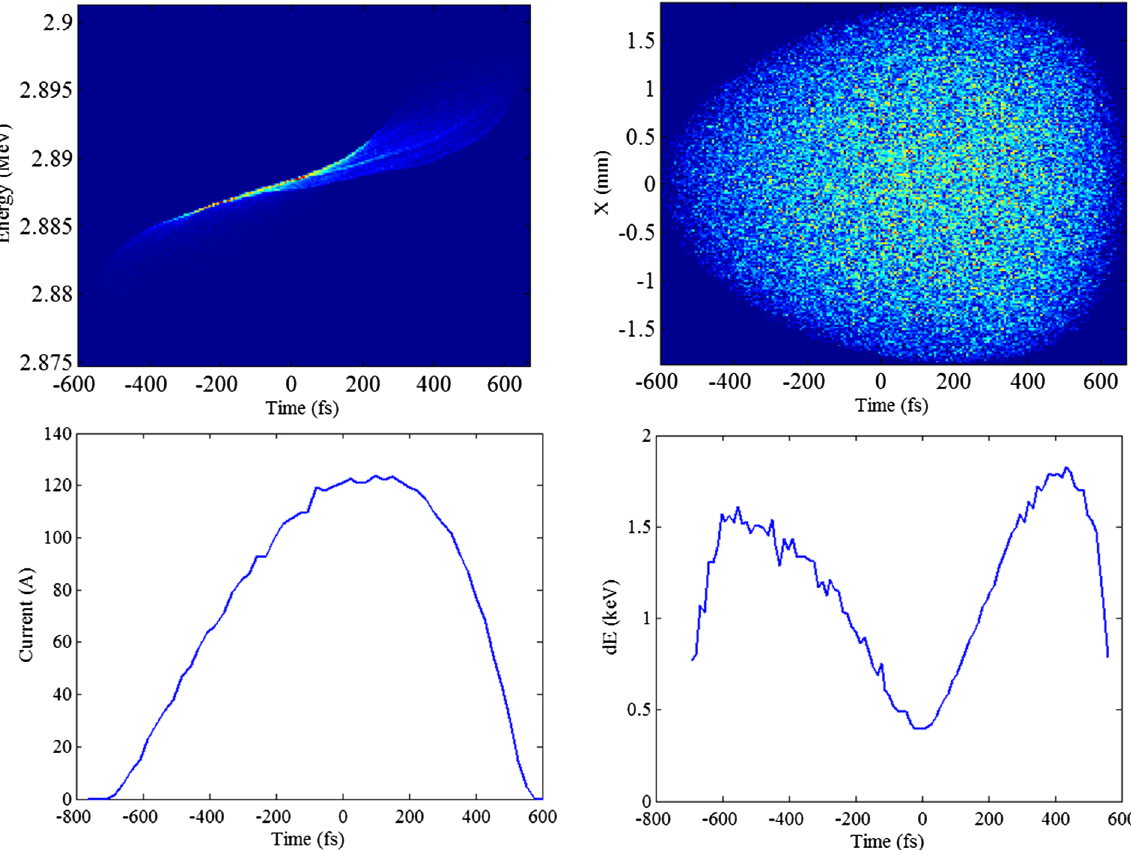
FIG. 10. Plots of longitudinal electron beam parameters at gun exit vs time relative to bunch center. The upper left shows time-energy phase space with mean energy of 2.89 MeV and rms bunch length of 260 fs ( ∼ 1 ° rf). The upper right shows ellipsoidal distribution resulting from blowout mode dynamics. The lower left shows 120 A peak current and the lower right shows energy spread that is higher in the head tail; however, energy spread remains below 2 keV for all time slices. The bunch length has expanded by a factor of 4 from the cathode laser pulse length as required by blowout mode